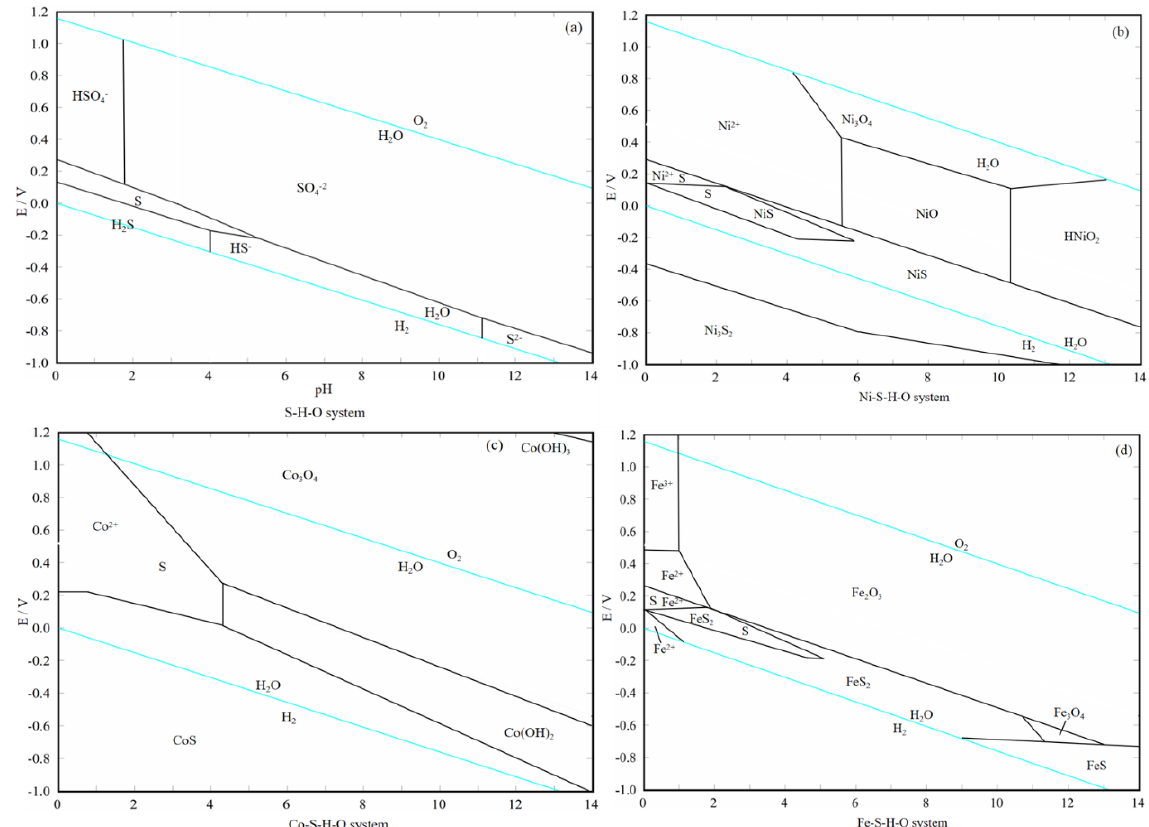
Figure 8. E – pH diagrams for different systems at 110 °C and 1.0 MPa. Figure 8. E–pH diagrams for different systems at 110 ◦ C and 1.0